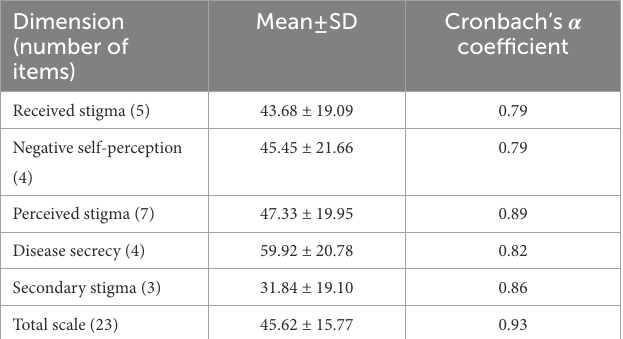
TABLE 4 Scale descriptive statistics and reliability